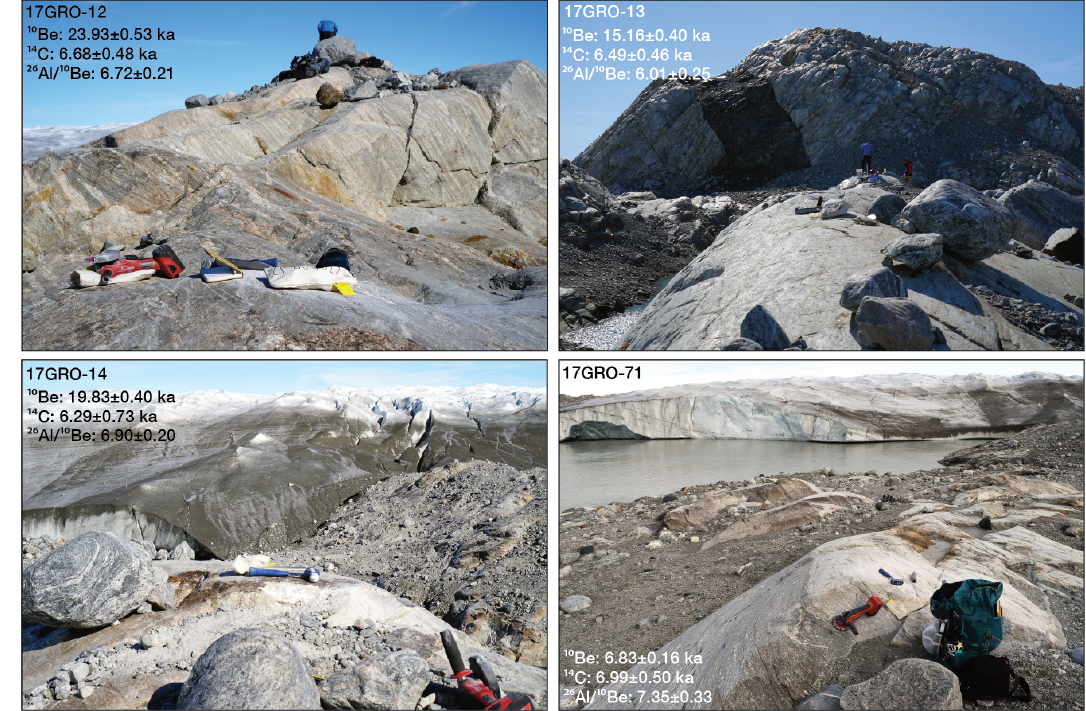
Figure 12. Sampled bedrock surfaces adjacent to the modern ice margin on the northeastern side of